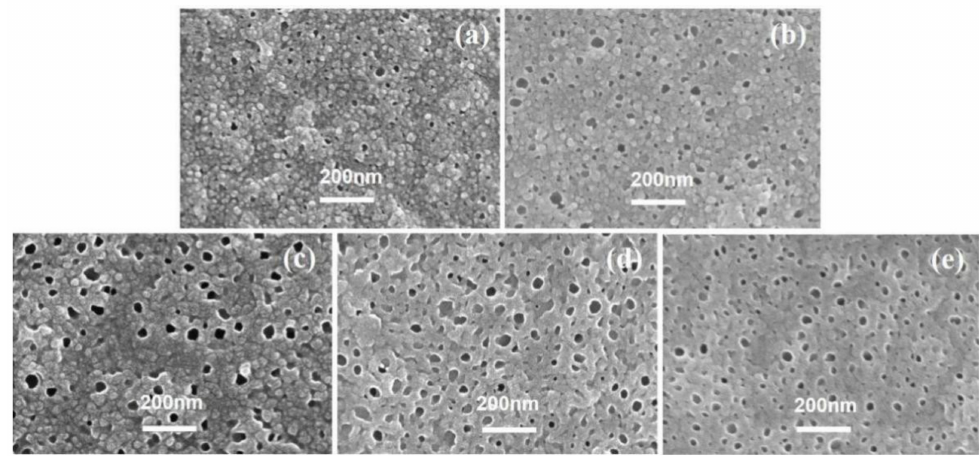
Figure 8. SEM images of PA’s backside in series 3, ( a – e ): TFC − 14~TFC −